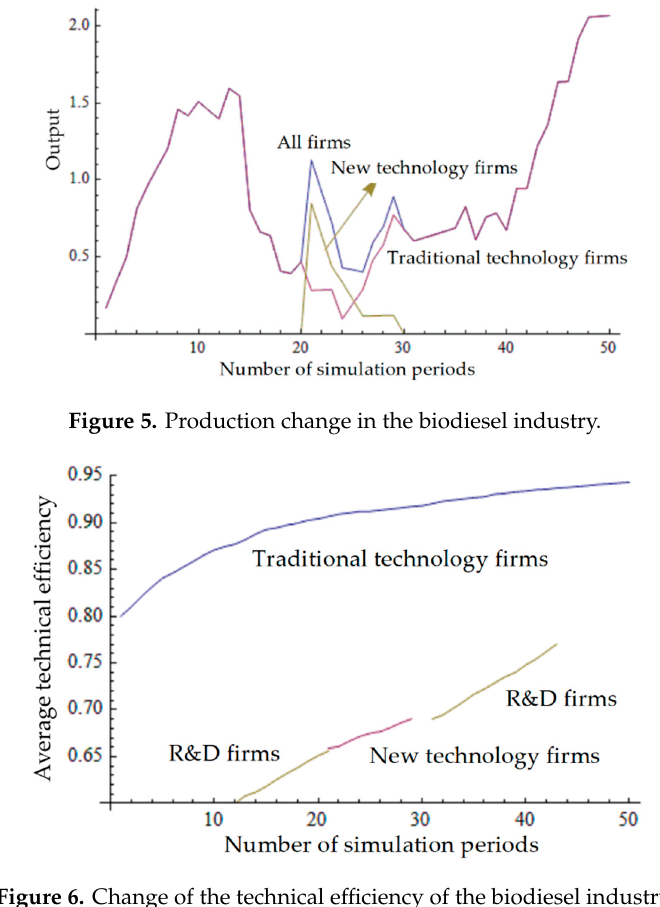
Figure 6. Change of the technical efficiency of the biodiesel industry.